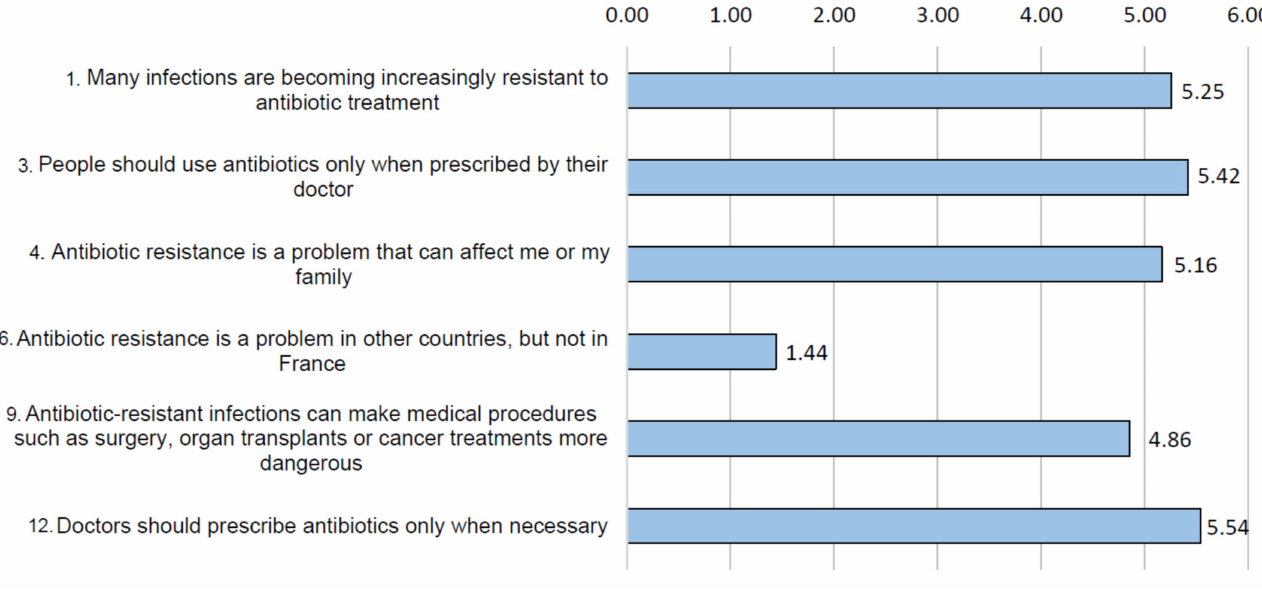
Figure 3. Mean score obtained by respondents for concern about risk perception and appropriate practices concerning ABR risk (question #8, items 1, 3, 4, 6, 9, 12; score from 1 to 6).